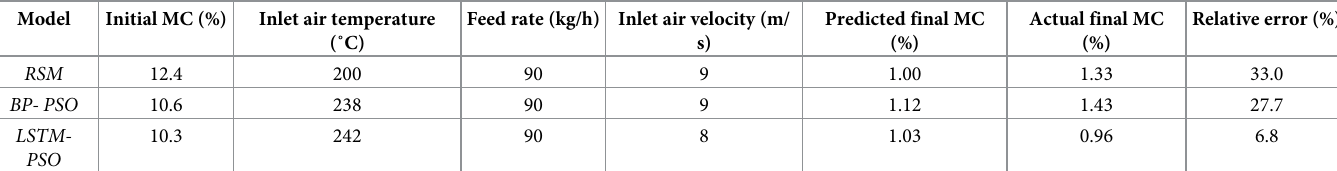
Table 7. Comparison and verification of different methods for Optimizing ICD.